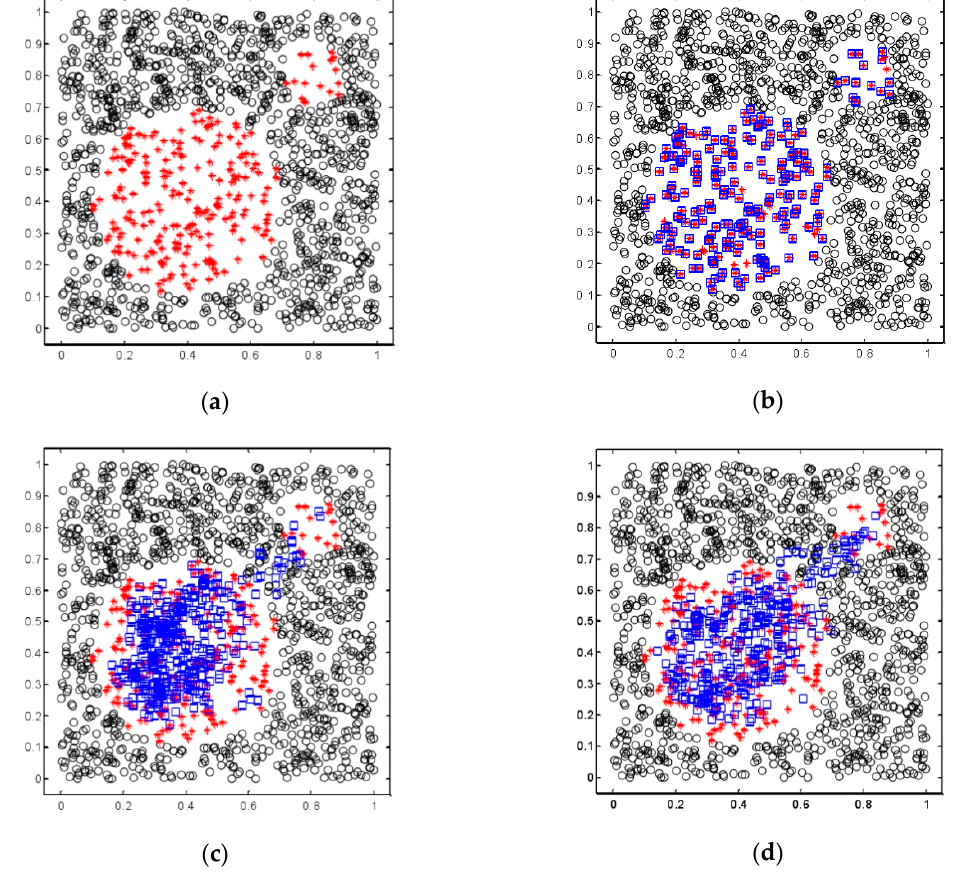
Figure 5. Schematic diagram of samples generated by different oversampling methods. ( a ) Raw data , ( b ) random oversampling, ( c ) synthetic minority oversampling technique, ( d ) improved SOMTE based on K-means. red: electricity theft users; Blue: data generated after oversampling; GREY: normal users. Table 3. The schematic of OOB.